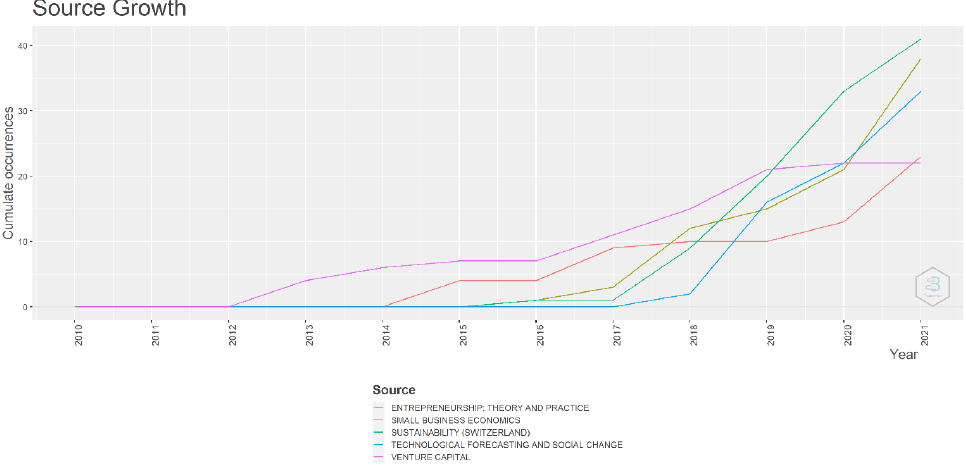
Figure 5. Source growth in the research domain of crowdfunding.